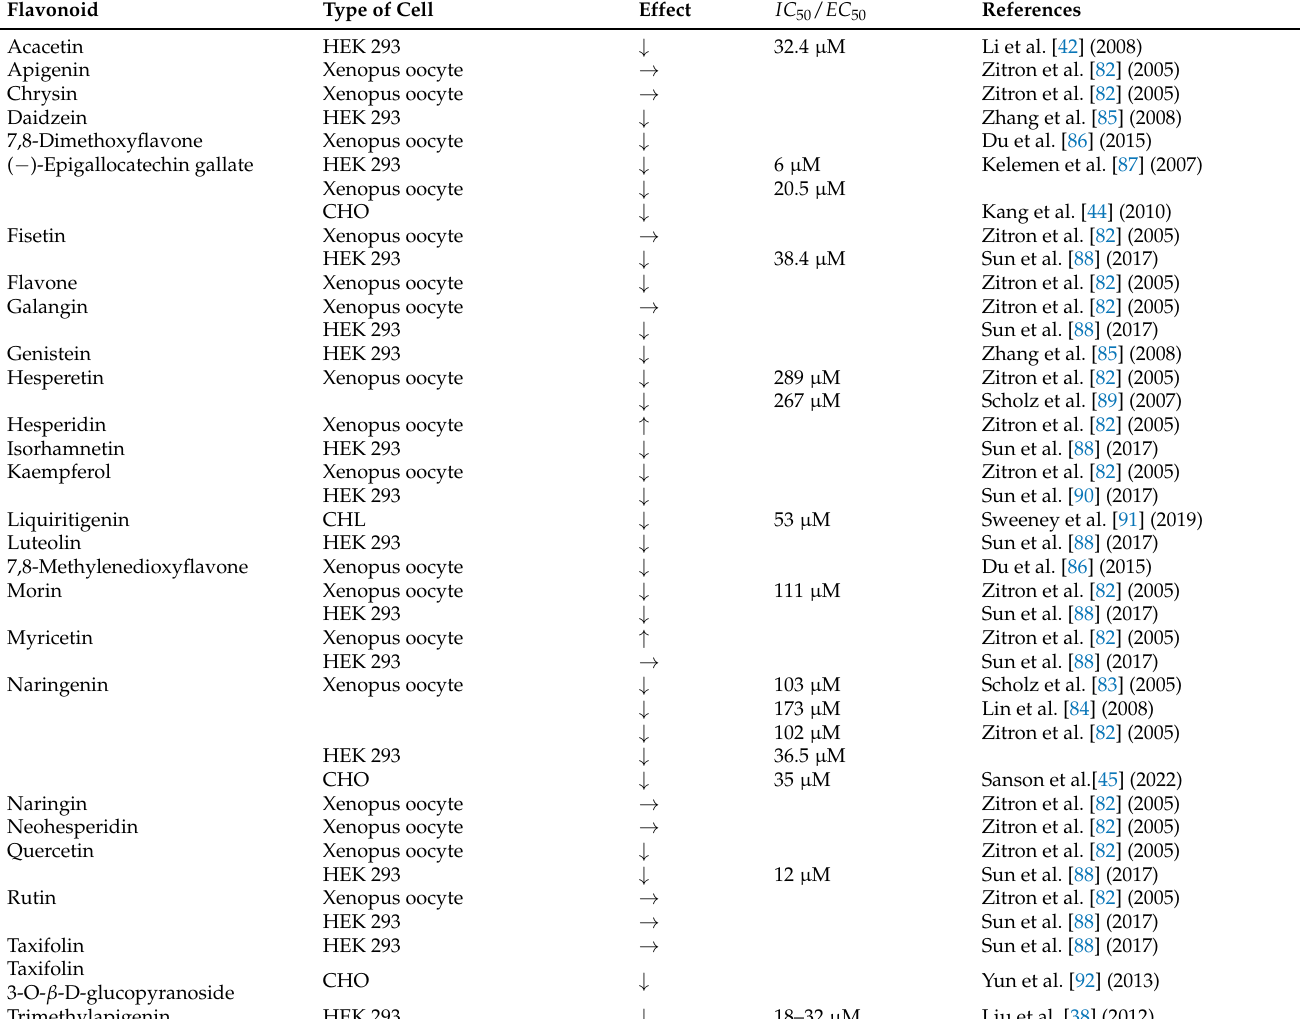
Table 2. The effects of different flavonoids on the activity of Kv11.1 (hERG) channels. EC 50 is the concentration of a flavonoid that gives a half-maximal response. IC 50 is the concentration of a flavonoid concentration at 50% channel inhibition. The arrows symbolize the type of observed effects on the channel activity: ↓ inhibition, ↑ activation, → no effect. The table is in most part adapted from [81] with permission from Elsevier